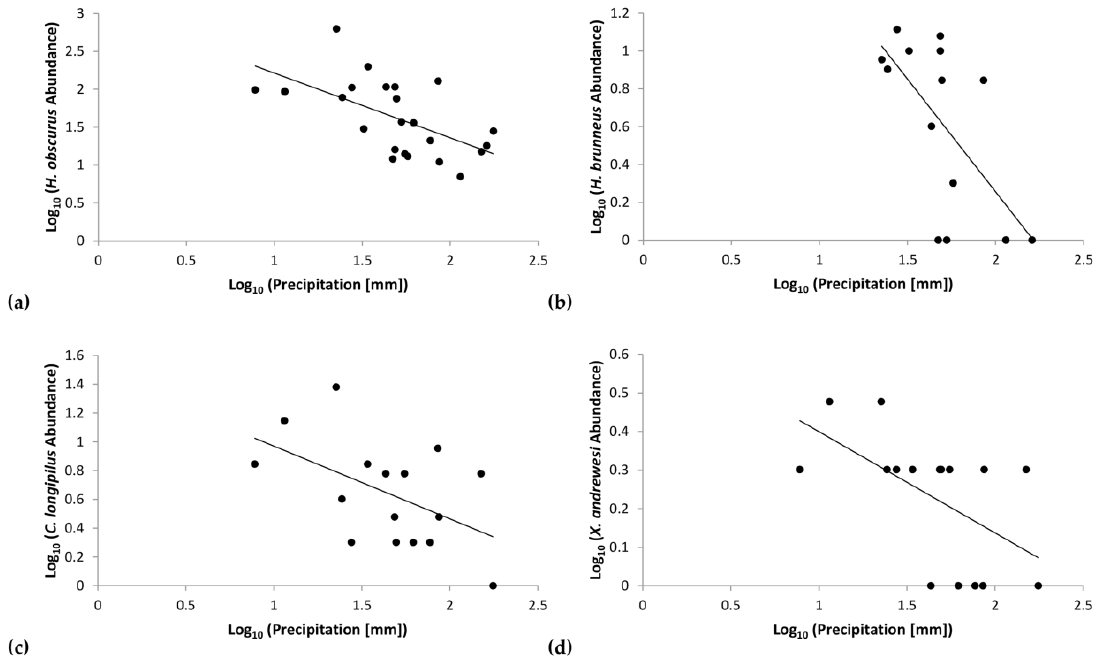
Figure 6. Regression of log-transformed data correlating precipitation and abundance of ( a ) Hypothenemus obscurus , ( b ) H. brunneus , ( c ) Cryphalus longipilus , and ( d ) Xyleborinus andrewesi .